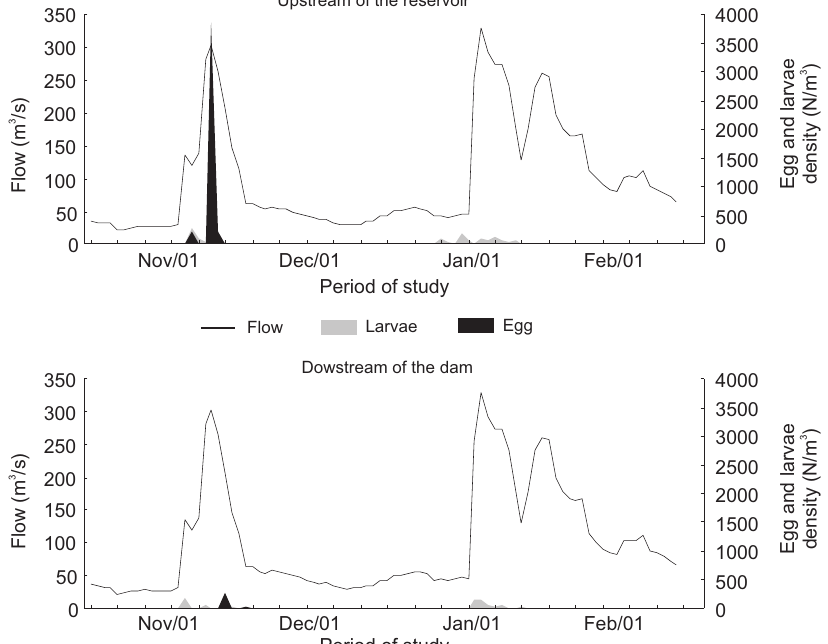
Figure 2. Density of fish eggs and larvae obtained upstream of the reservoir and downstream of the Santa Clara dam, and the flow-rate of the Mucuri River, between October 15 th 2002 and February 15 th